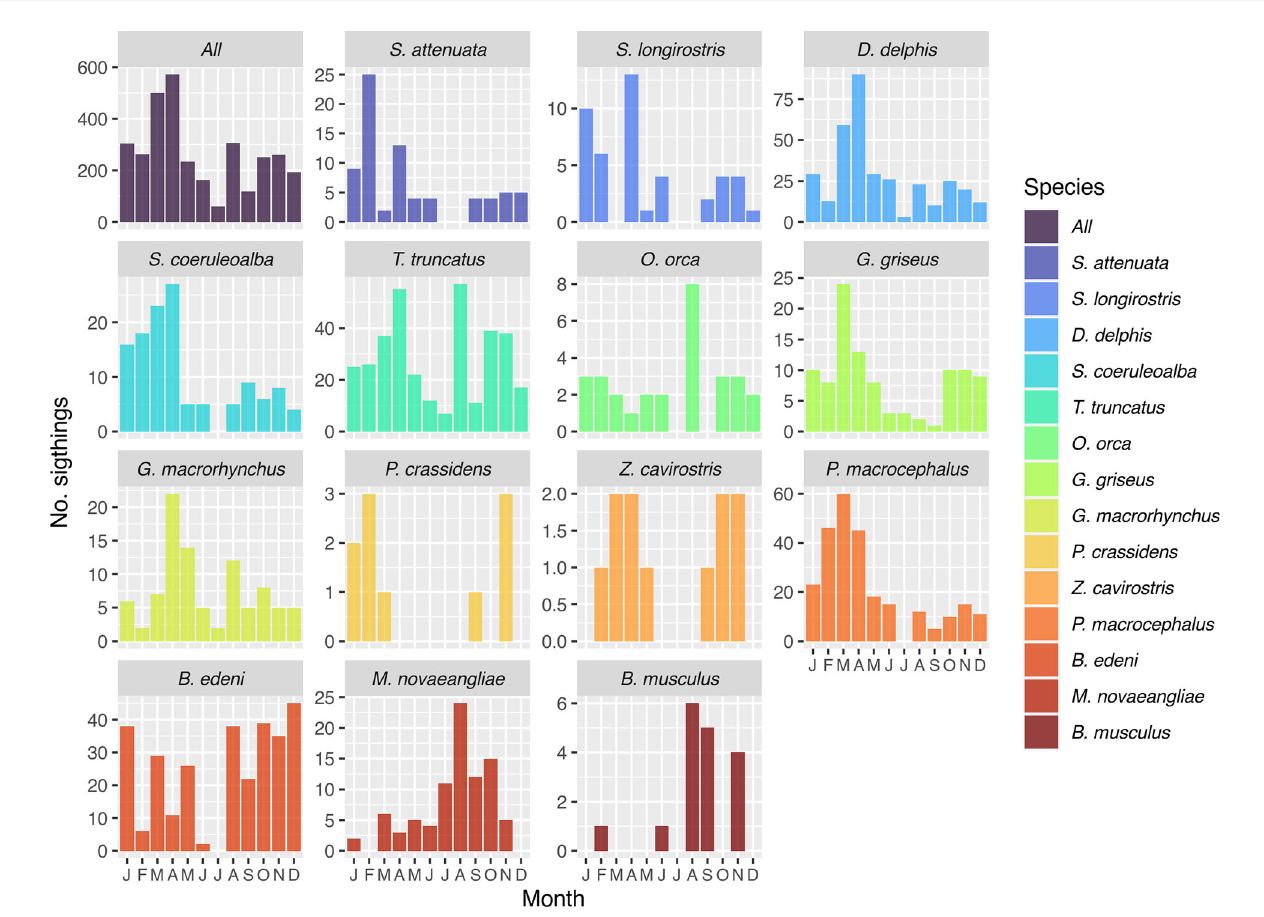
FIGURE 4 Histogram plots of number of sightings by month for 14 cetacean species commonly seen in Gala ́ pagos waters. Marine mammal sighting data from Palacios (1999b); Palacios and Salazar (2002); Palacios (2003), Fe ́ lix et al. (2011), and Cantor et al. (2017), used with permission or under Creative Commons licenses CC BY and CC